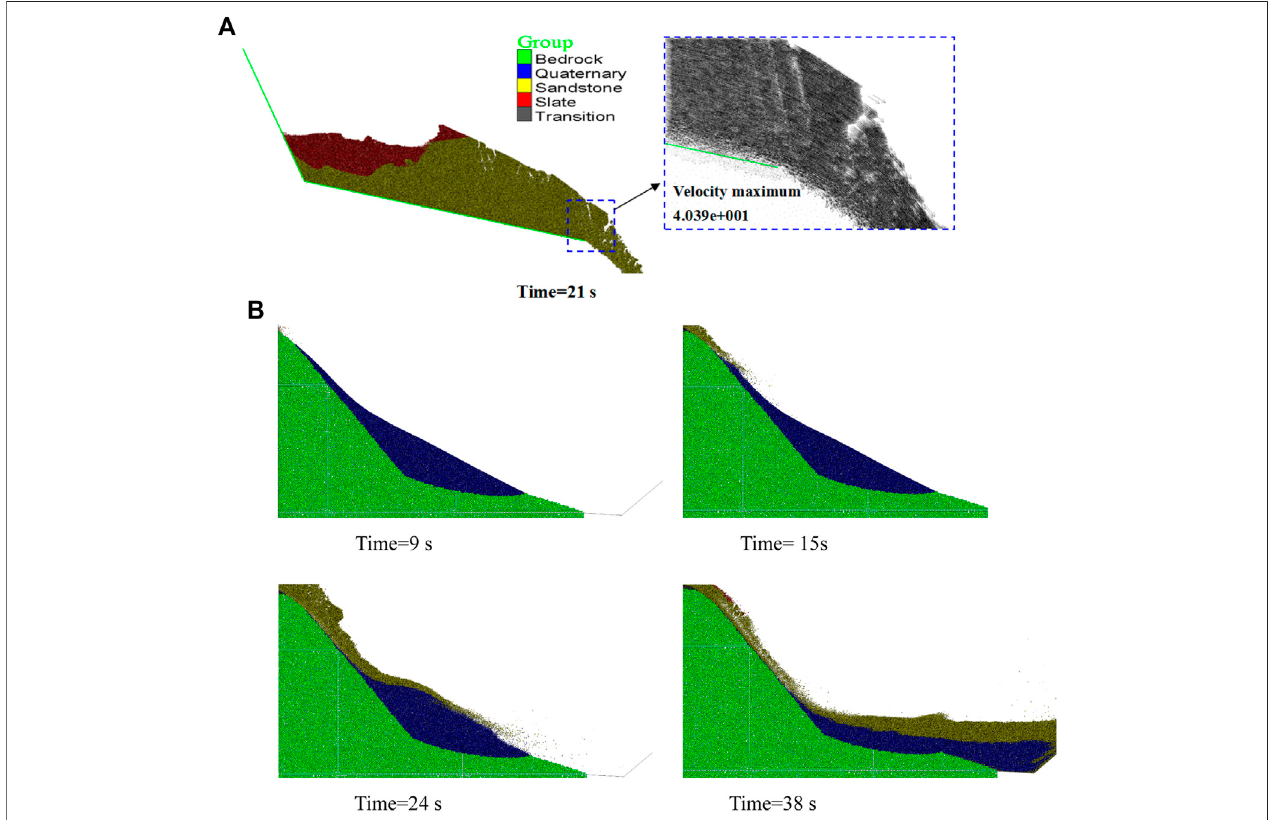
FIGURE10|(A) Projectilemotion:thetoeoftheslidingsurfaceprojectstheupperslidingmassintotheair. (B) Scrapingactionoftheupperslidingmasstowardthe Quaternary colluvial and eluvial deposit covering the lower cliff.